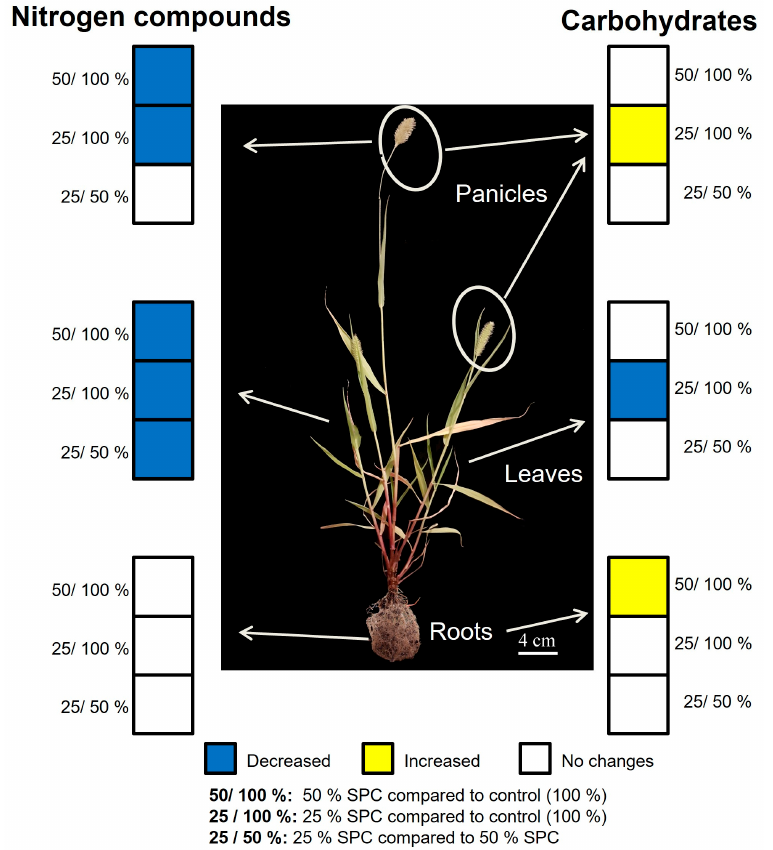
Figure 7. Nitrogen compound ( left ) and carbohydrate ( right ) production in response to water restriction (50% and 25% of soil pot capacity—SPC) observed in each organ (roots, leaves or panicles) of S. viridis . The content of the compounds represents the sum of the quantity of all the different compounds belonging to each class detected and quantified by GC-MS. The colors represent the increase (yellow), decrease (blue) or lack of changes (white) in the total content of these compounds comparing the different water treatments, as specified, and according to the ANOVA analysis ( p ≤ 0.05, n = 5).